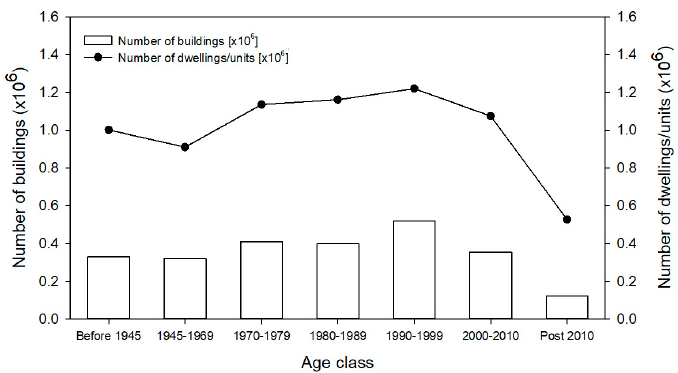
Figure 1. Building stock in Portugal considering construction age class (data source [32]).